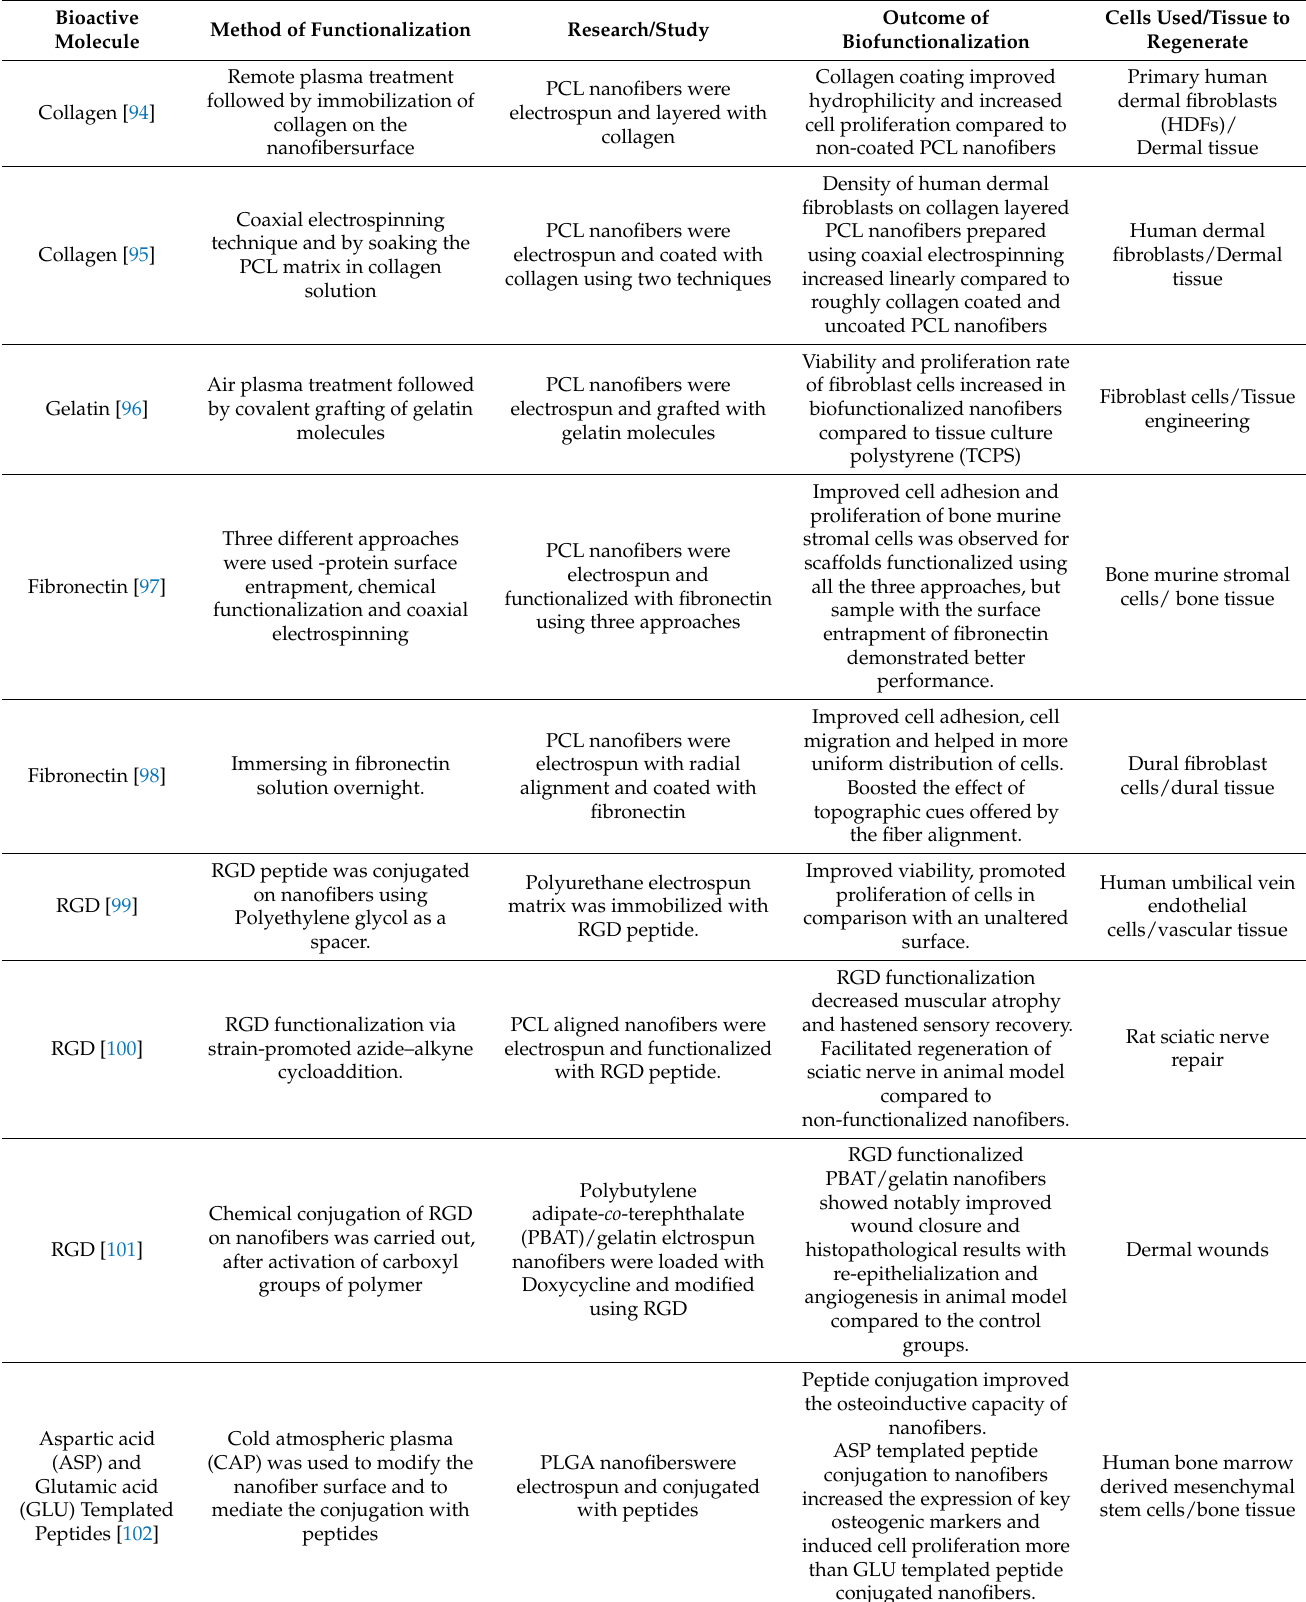
Table 3. Functionalization with bioactive molecules and their applications in tissue